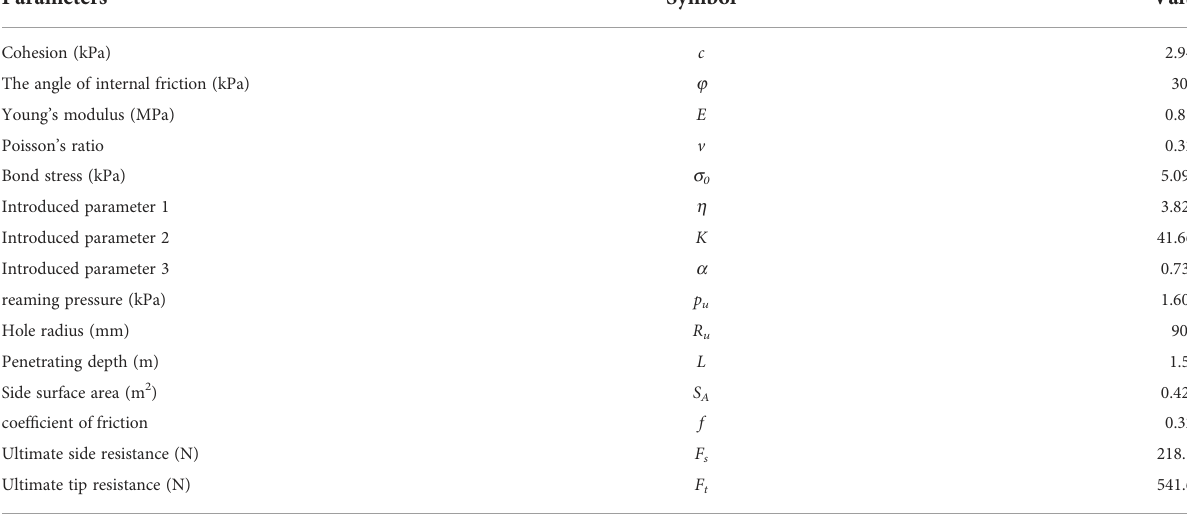
TABLE 2 The parameters for resistance calculation.